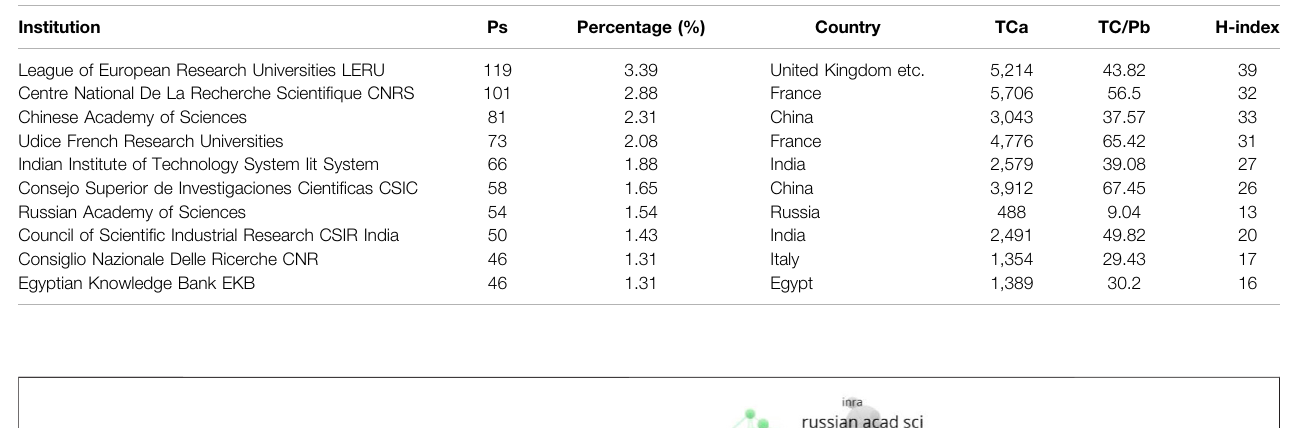
TABLE 3 | Top 10 most productive institutions in terms of relevant articles.